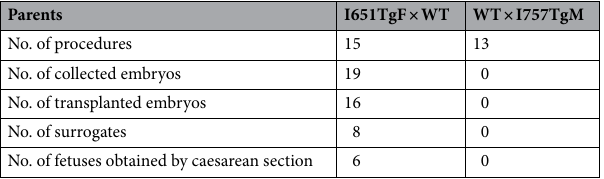
(Fig. S7, Table S3 and S4). At E89, an earlier stage, pan-GPR56 positive cells included almost all Nkx2.1 positive progenitor cells in presumptive MGE (medial ganglionic eminence), from which GABAergic neurons originate (Fig. S8A) 28 . At E95, EGFP positive migrating neurons were observed beneath and within the intermediate zone (Fig. S8B). These findings are consistent with the fact that hGPR56 e1m drives protein expression preferentially in GABAergic neurons. Furthermore, we examined the subtype of the EGFP-positive GABAergic interneurons